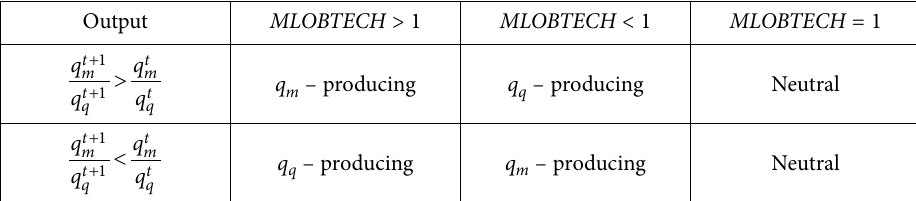
Table 2. Changes in the output mix and output biased technological change Output MLOBTECH > 1 MLOBTECH <